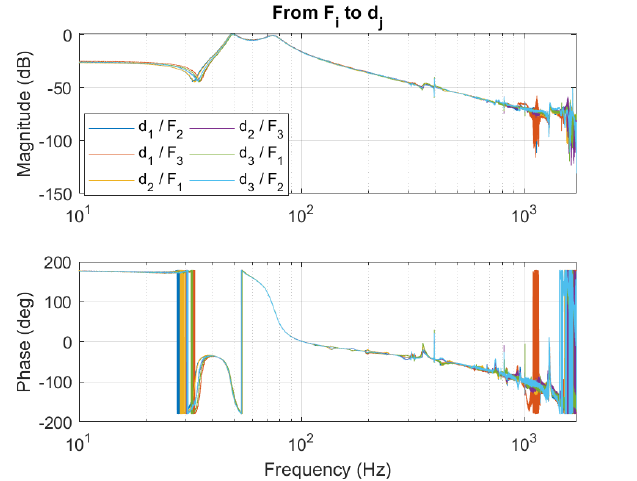
Figure 12. The cross-coupled frequency response functions of the Flowerbed, the phase is shifted upwards by 180 degrees since the position is measured in opposite direction to applied force.